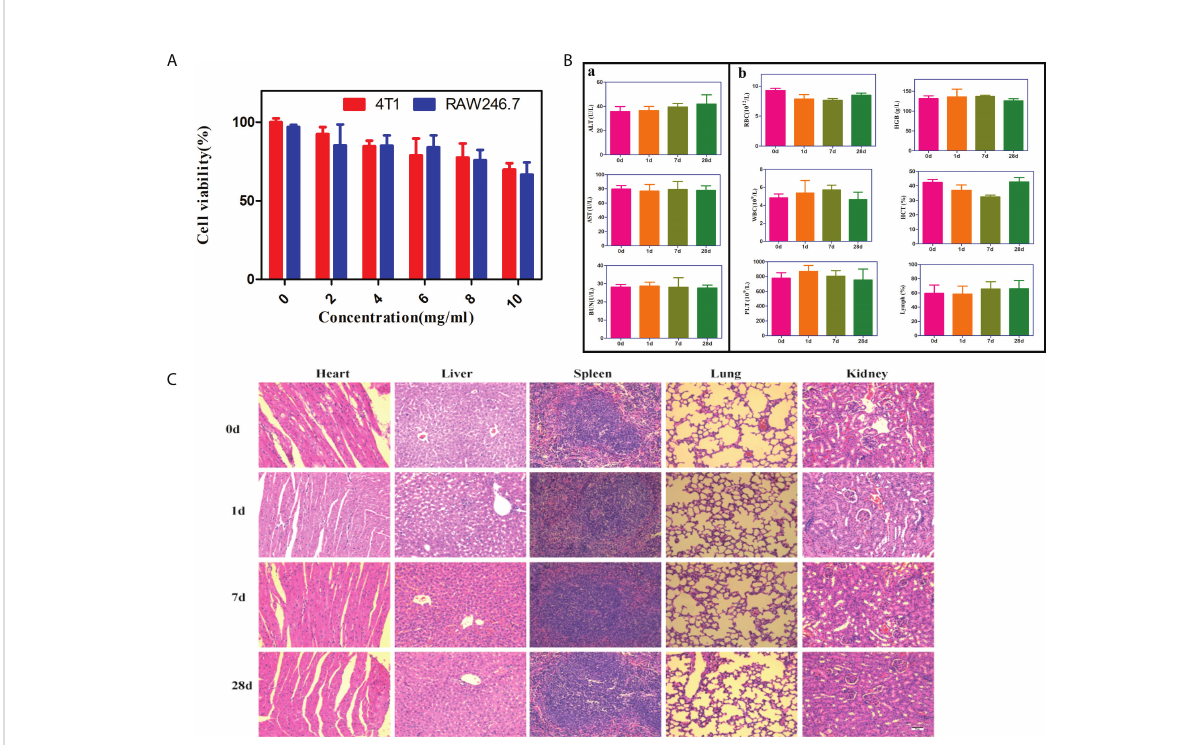
FIGURE 2 In vitro and in vivo biosafety of PFH/ART@PLGA/Fe 3 O 4 -eFA. (A) The biocompatibility of different concentrations of PFH/ART@PLGA/Fe 3 O 4 -eFA NPs was determined by a standard CCK-8 assay. (B) Routine blood and biochemical tests were performed at different times (0, 1, 7, 28d) after the injection of NPs. ① The changes of liver function (ALT and AST) and renal function (BUN) in mice. ② The results of routine blood tests (WBC, RBC, HGB, HCT, PLT and MPV). (C) The H&E staining results of the liver, spleen, heart, lungs and kidneys of the mice at different time points (0, 1, 7, 28d) after the injection of PFH/ART@PLGA/Fe 3 O 4 -eFA (The scale bar is 50µm). All the error bars represent the standard deviations. n =